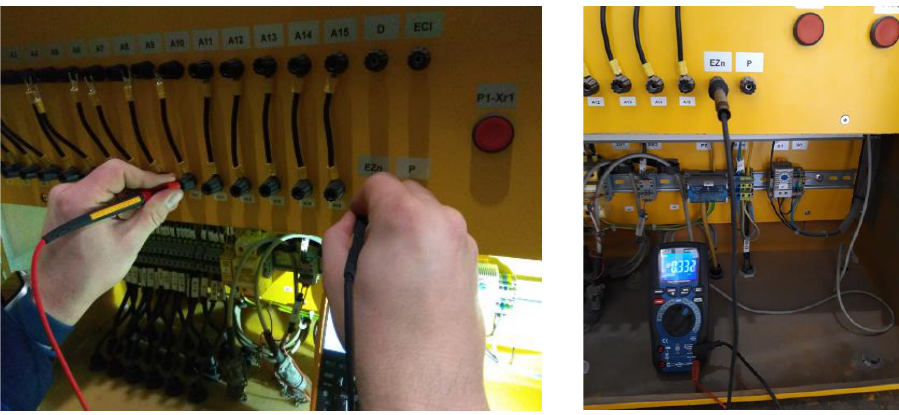
Figure 13. Measurement of the operating parameters of the protection installation element inside the polarizer cabinet.